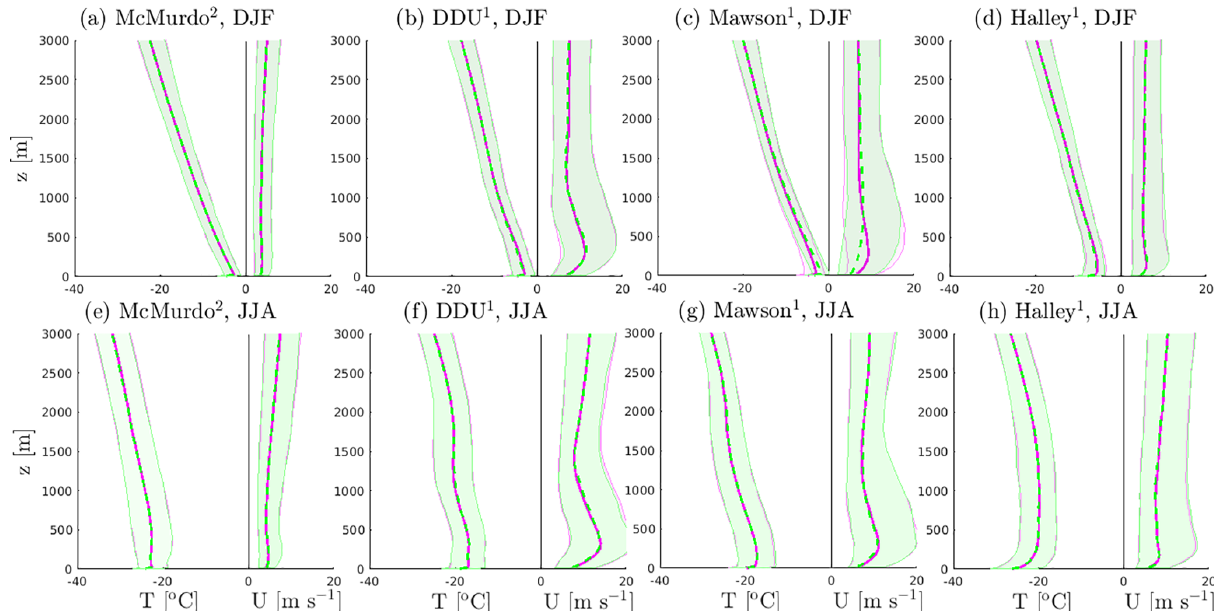
Figure 10. Vertical statistics of temperature (left part of panels) and wind speed (right part of panels) in DJF (top row) and JJA (bottom row) from ERA5 reanalyses at four Antarctic stations. Dashed green lines (solid magenta lines) show the medians of the ERA5 data set restricted to radiosonde launching times (of the full ERA5 data set). Color shadings delimit the associated 80–20th interquartiles. Numbers in exponential form next to station names in the title indicate the number of radiosoundings per day at the corresponding station.